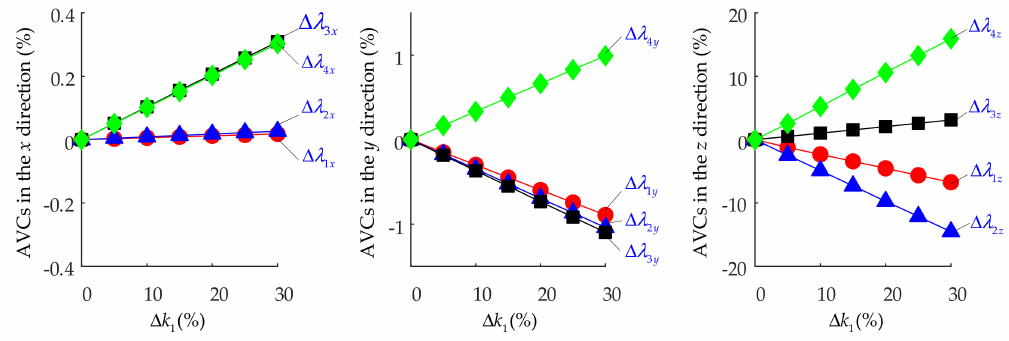
Figure 6. The amplitude variation coe ffi cient (AVC) curves of each spring seat in the x , y , and z directions in the case of k 1 failure.